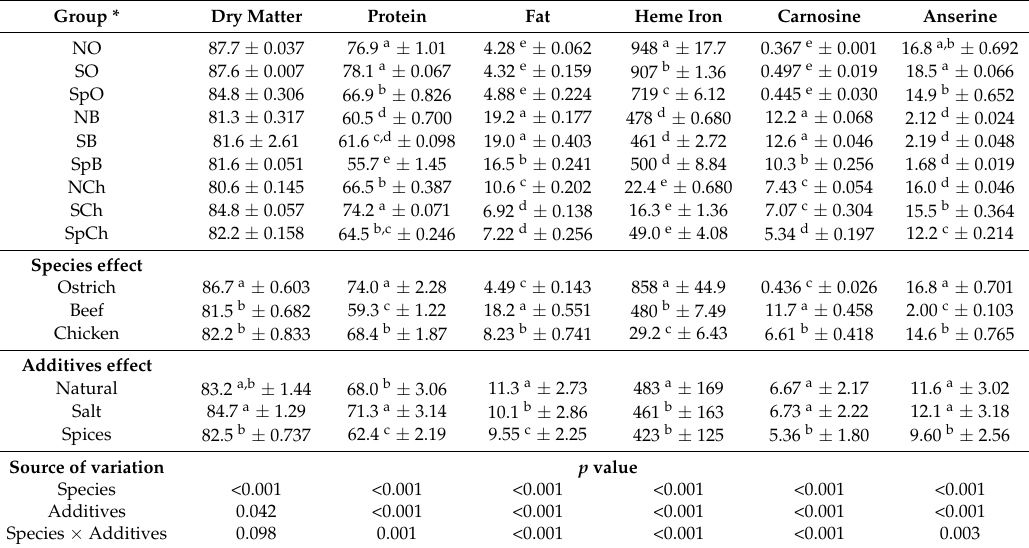
<0.001 <0.001 <0.001